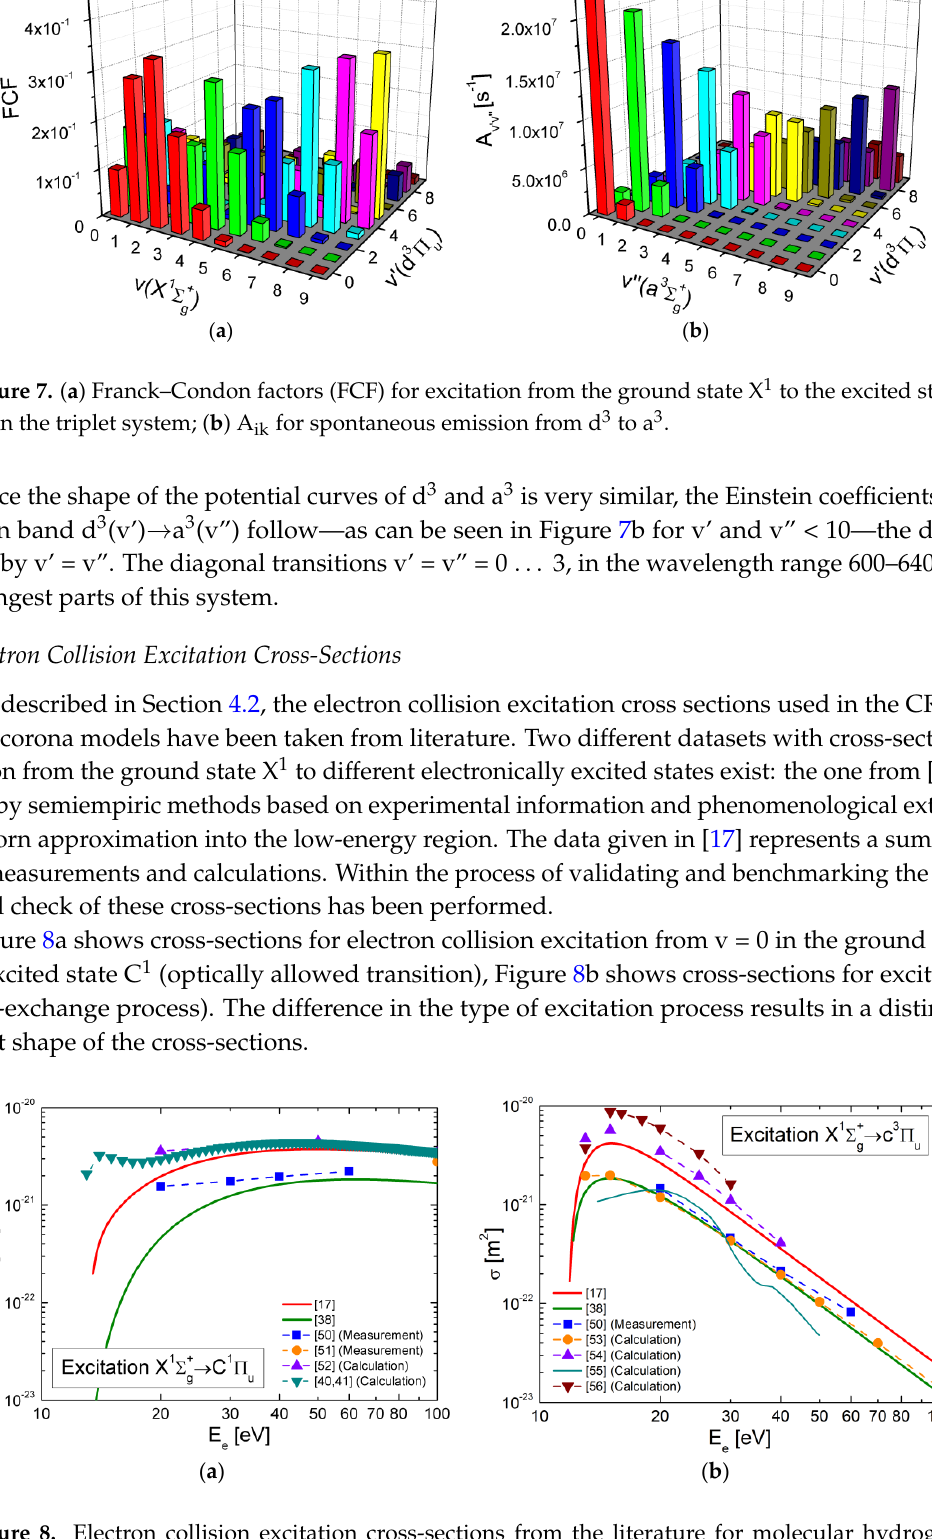
Figure 8. Electron collision excitation cross-sections from the literature for molecular hydrogen: ( a ) excitation from the ground state X 1 to the excited state C 1 in the singlet system; ( b ) excitation from the ground state X 1 to the excited state c 3 in the triplet system.